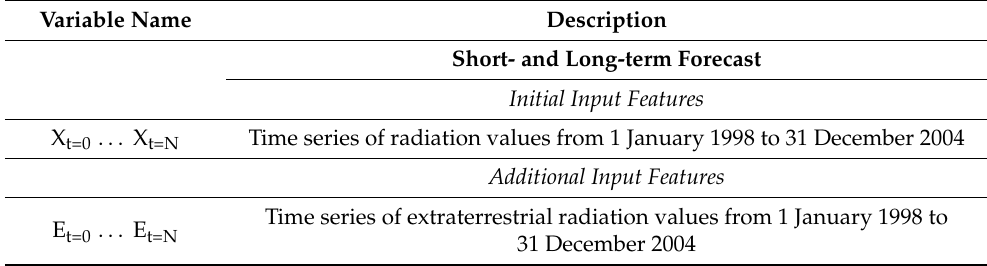
Table 3. Initial and additional features for FBP short- and long-term